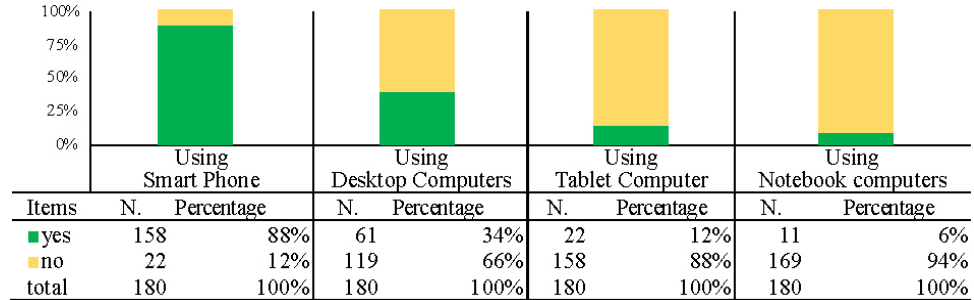
Figure 8. Descriptive statistical results for participants’ device selection for self-media surfing.